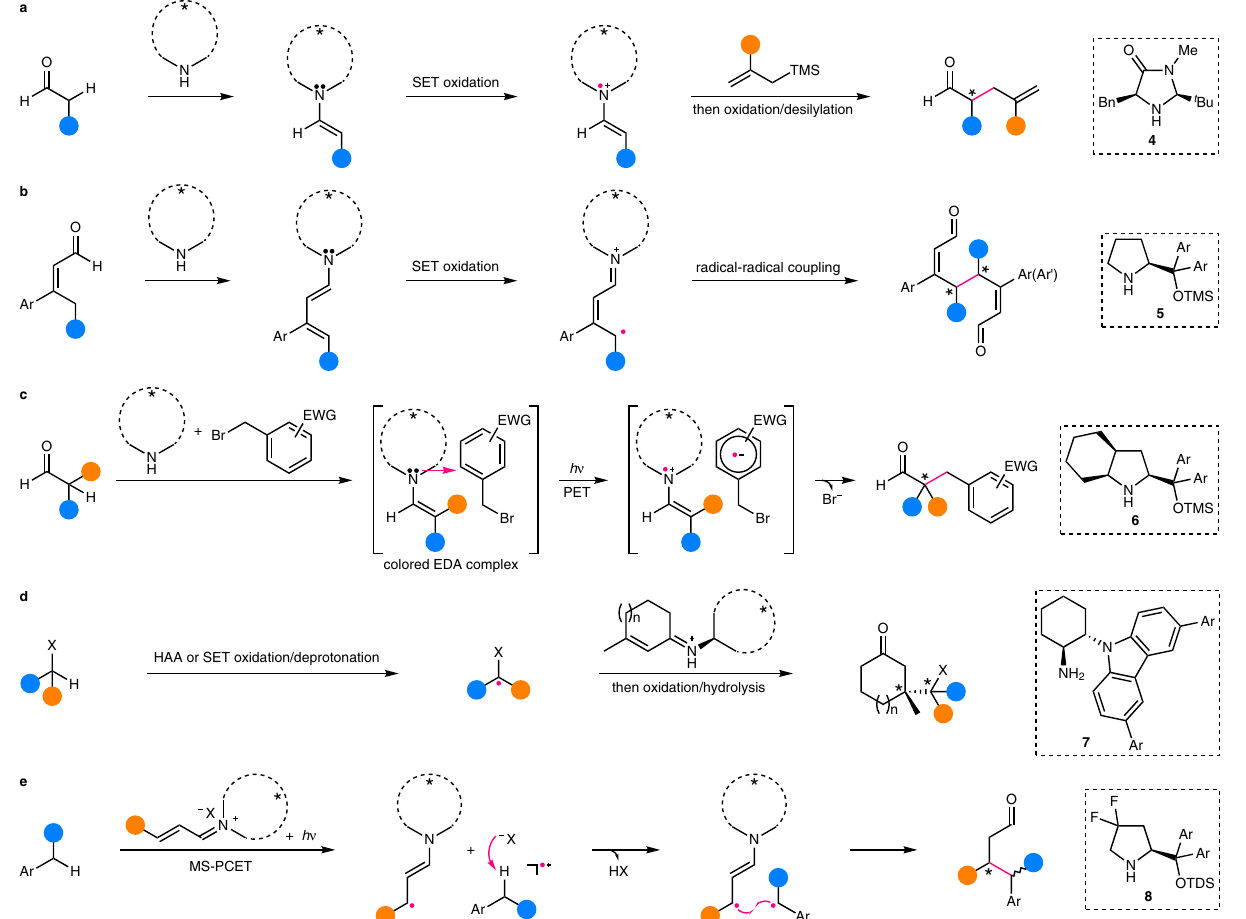
Fig. 4 Examples of enantiocontrol by chiral amine catalysts in enantioselective C( sp 3 ) – H functionalization. a Enantioselective addition of C – H-derived chiral amine-bonded prochiral radicals to free π -acceptors. b Enantioselective homo-/heterocoupling of C – H-derived chiral amine-bonded prochiral radicals. c Enantioselective coupling of C – H-derived chiral amine-bonded prochiral radicals with another type of radicals within the solvent cage of their origin. d Enantioselective addition of C – H-derived free achiral/prochiral radicals to chiral amine-bonded π -acceptors. e Enantioselective coupling of C – H- derived free achiral/prochiral radicals with another type of chiral amine-bonded radicals. TMS trimethylsilyl, EWG electron-withdrawing group,